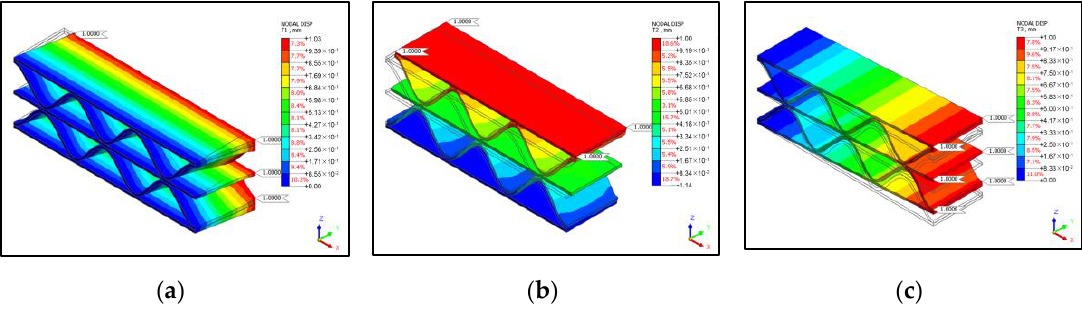
Figure 15. Directional reaction force for the unit cell of BB/F-DW corrugated paperboard, they should be list as: ( a ) xy -direction; ( b ) yz -direction; ( c ) zx -direction.